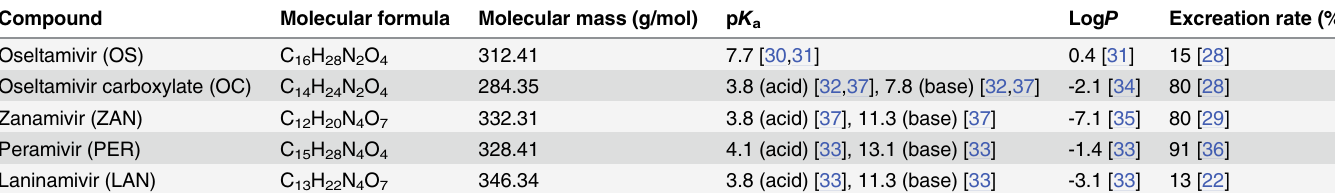
Table 1. Chemical structures and physicochemical properties of the anti-influenza drugs examined [22, 28 – 37]. Compound